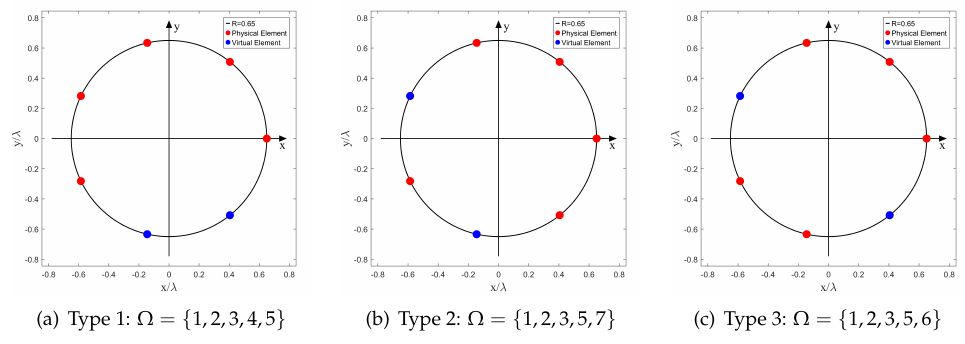
Figure 3. Different Array Configurations, ( N = 7, N p =